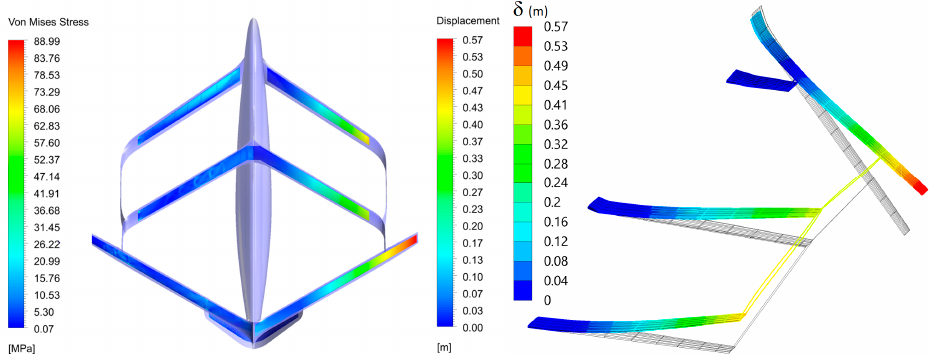
Figure 23. BWA/SL aircraft in cruise flight condition S 3 (M = 0.7 at 43,000 ft) with an angle-of-attack α = 0°. ( Left ): Stress distribution (left wing) and deflection (right wing) exerted by the aircraft planform. ( Right ): Deflection of the three wings (visual rendering is here exacerbated on purpose).